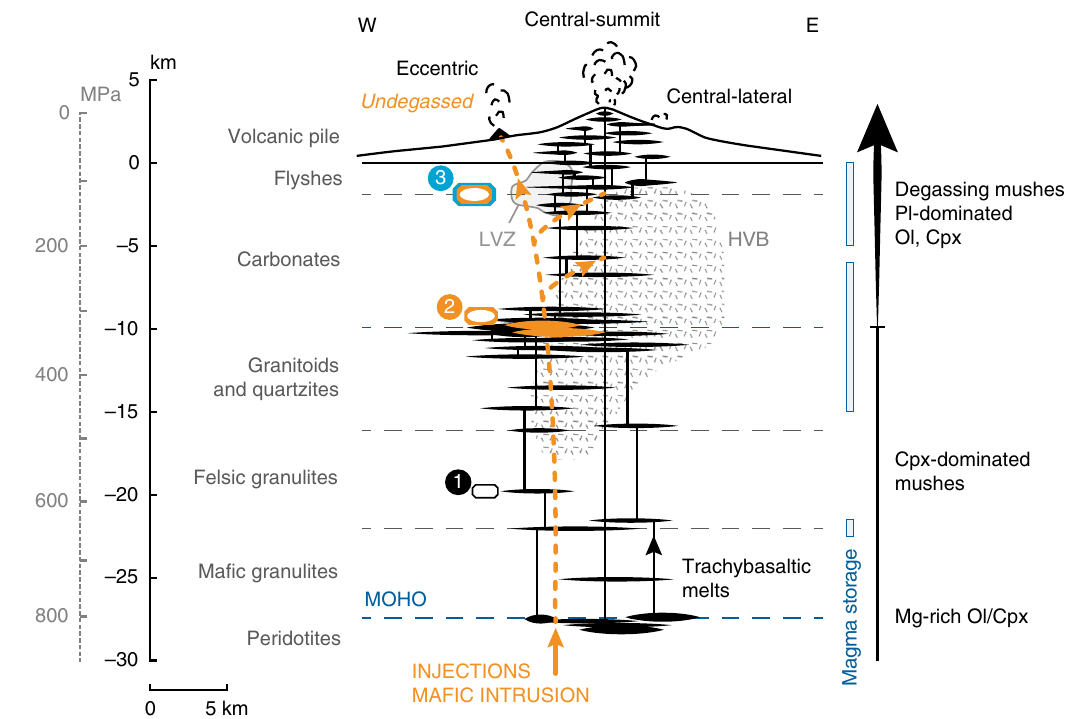
Fig. 7 Schematic interpretation of the crustal plumbing system feeding Mt. Etna. The transcrustal magma plumbing system is composed of multi-level mush regions, concentrated along stratigraphic boundaries (crustal stratigraphy and rock densities for pressure scale are after refs. 78 and 79 ; see also Fig. 4). Our data support a main storage region at ~10 km depth, at the transition between the crystalline basement and the sedimentary sequence. Magma ascent is interpreted between the high-Vp body (HVB; depth range and dimensions after ref. 52 ), detected below the summit and eastern Valle del Bove caldera and considered a major solidi fi ed plutonic complex, and the shallow low-Vp zone (LVZ) 49 – 52 . Magma storage depths inferred from geophysical data are represented with vertical blue bars 49 – 53 . A wide region of low-Vp in the uppermost mantle ( < 34 km; below the sketch) is interpreted as the source region 52 . Mantle-derived magmas are buffered to trachybasaltic compositions at upper mantle to lower crustal levels, through continuous supply and mixing of primitive melts and crystallisation of Mg-rich olivine and clinopyroxene 26,31,32 . From the storage region at ~10 km and upwards, the system is governed by degassing and mixing in highly dynamic shallow mush pockets 32 , dominated by crystallisation of plagioclase 27 , olivine 29 and clinopyroxene. Since the 1970s, repeated batches of new ma fi c magma are intruding into and mixing with resident mushes. This magma has erupted quickly through deep dykes feeding eccentric eruptions and progressively migrated into the shallow, largely crystalline, and degassing central conduits (see yellow dashed pathways). Major and trace element zoning and thermobarometry of clinopyroxene can be explained by (1) recycling of low-mid crustal, relatively evolved mushes; (2) crystallisation of Cr-rich zones (yellow) from intruding magma in the main storage region; and (3) crystallisation of Cr-poor zones (blue) upon fi nal magma ascent and degassing. Progressive intrusion of primitive undegassed magma correlates with increasing eruptive activity in the last 40 years (Fig. 3). We calculate that the time elapsed between replenishment of the main storage system and eruption can be shorter than 2 weeks (Figs. 5 and